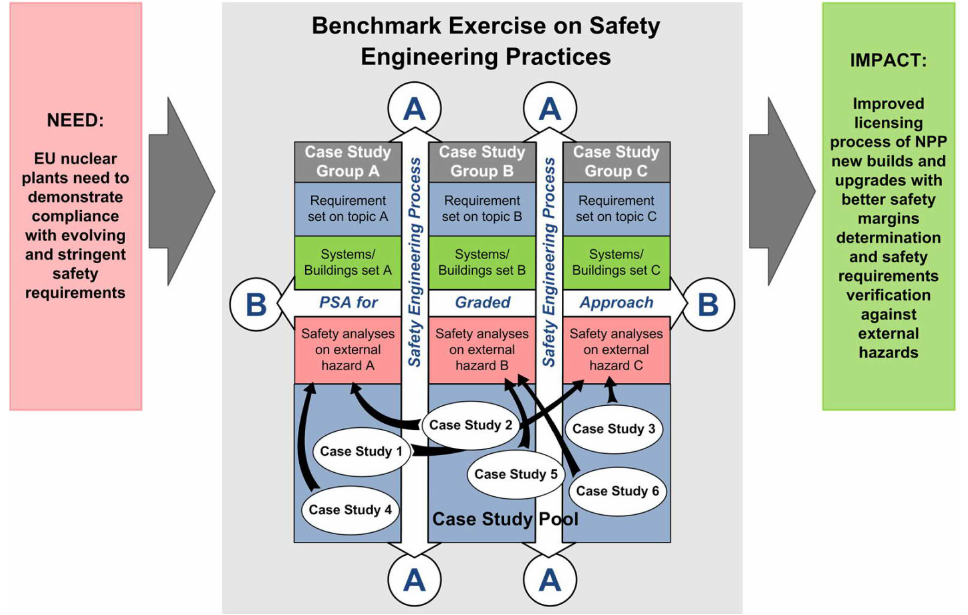
Fig. 6. The overall concept of BESEP